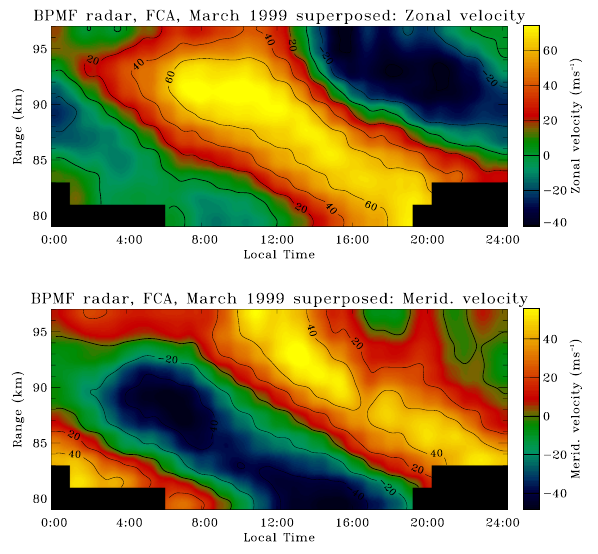
Fig. 5. Superposed epoch plot of the zonal (top) and meridional Figure6.SuperposedepochplotoftheturbulentvelocityforMarch1999. (bottom) velocity for March 1999.